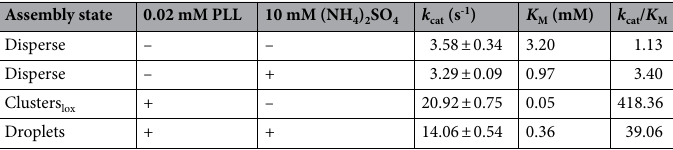
Table 1. Michaelis–Menten parameters for LOX in different assembly